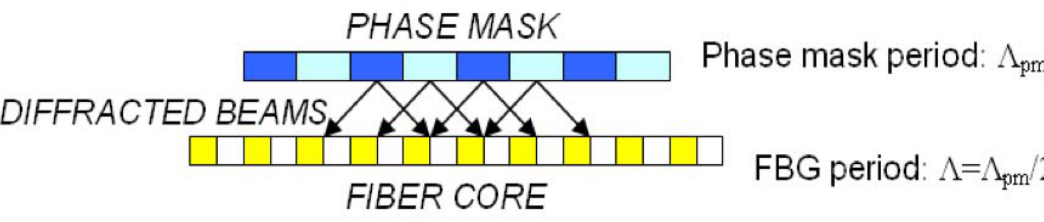
Figure 5. Schematic of the phase mask diffraction principle.